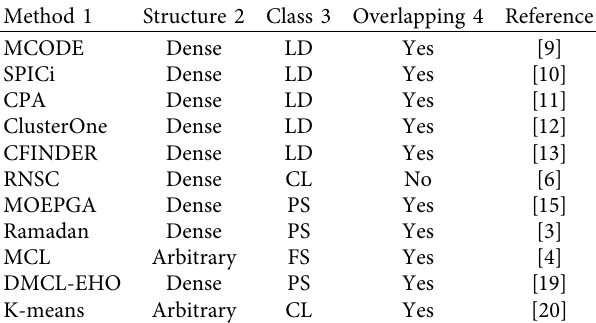
Table 1: Summary of some PPI networks clustering